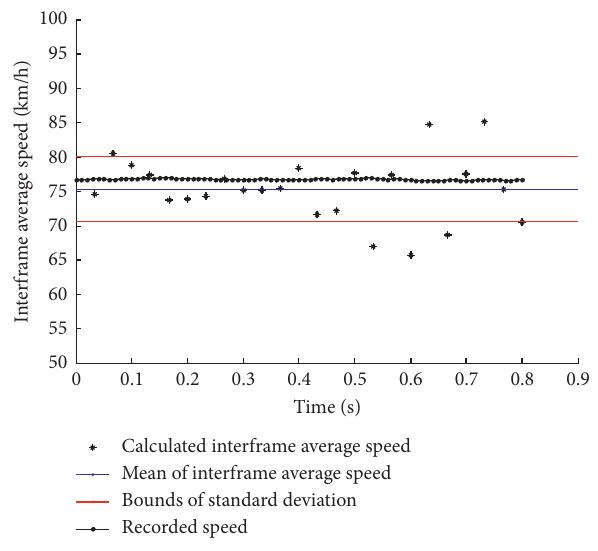
Figure 21: Compared analysis between v and v